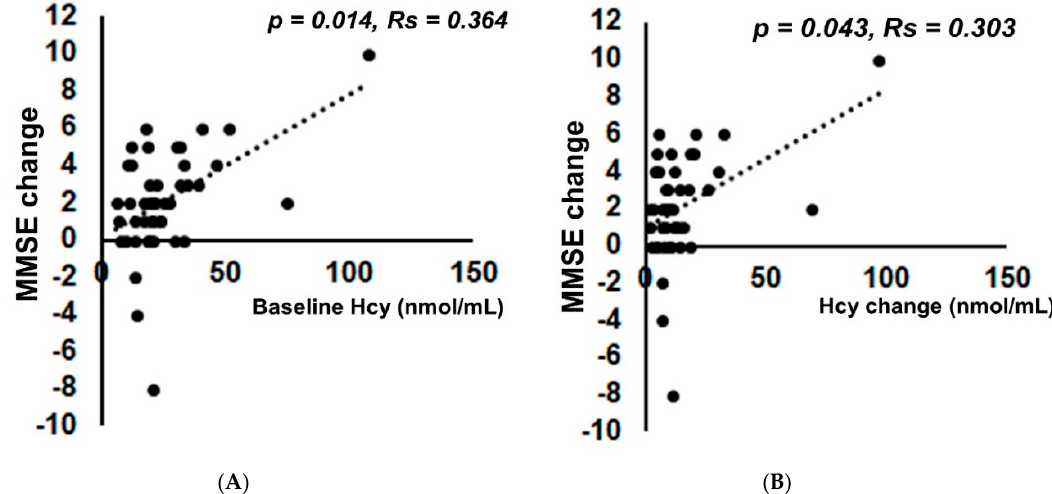
Figure 5. There was a significant positive correlation between MMSE score improvement after folate supplementation and the baseline homocysteine (Hcy) level or its reduction. ( A ) The degree of improvement of the MMSE score by folate supplementation and baseline homocysteine (Hcy) level were significantly correlated ( p = 0.014, Rs = 0.364). ( B ) The degree of improvement of the MMSE score by folate supplementation and baseline Hcy reduction were significantly correlated ( p = 0.043, Rs = 0.303). Spearman’s rank correlation coefficient was used for analysis because the data deviated from a normal distribution.